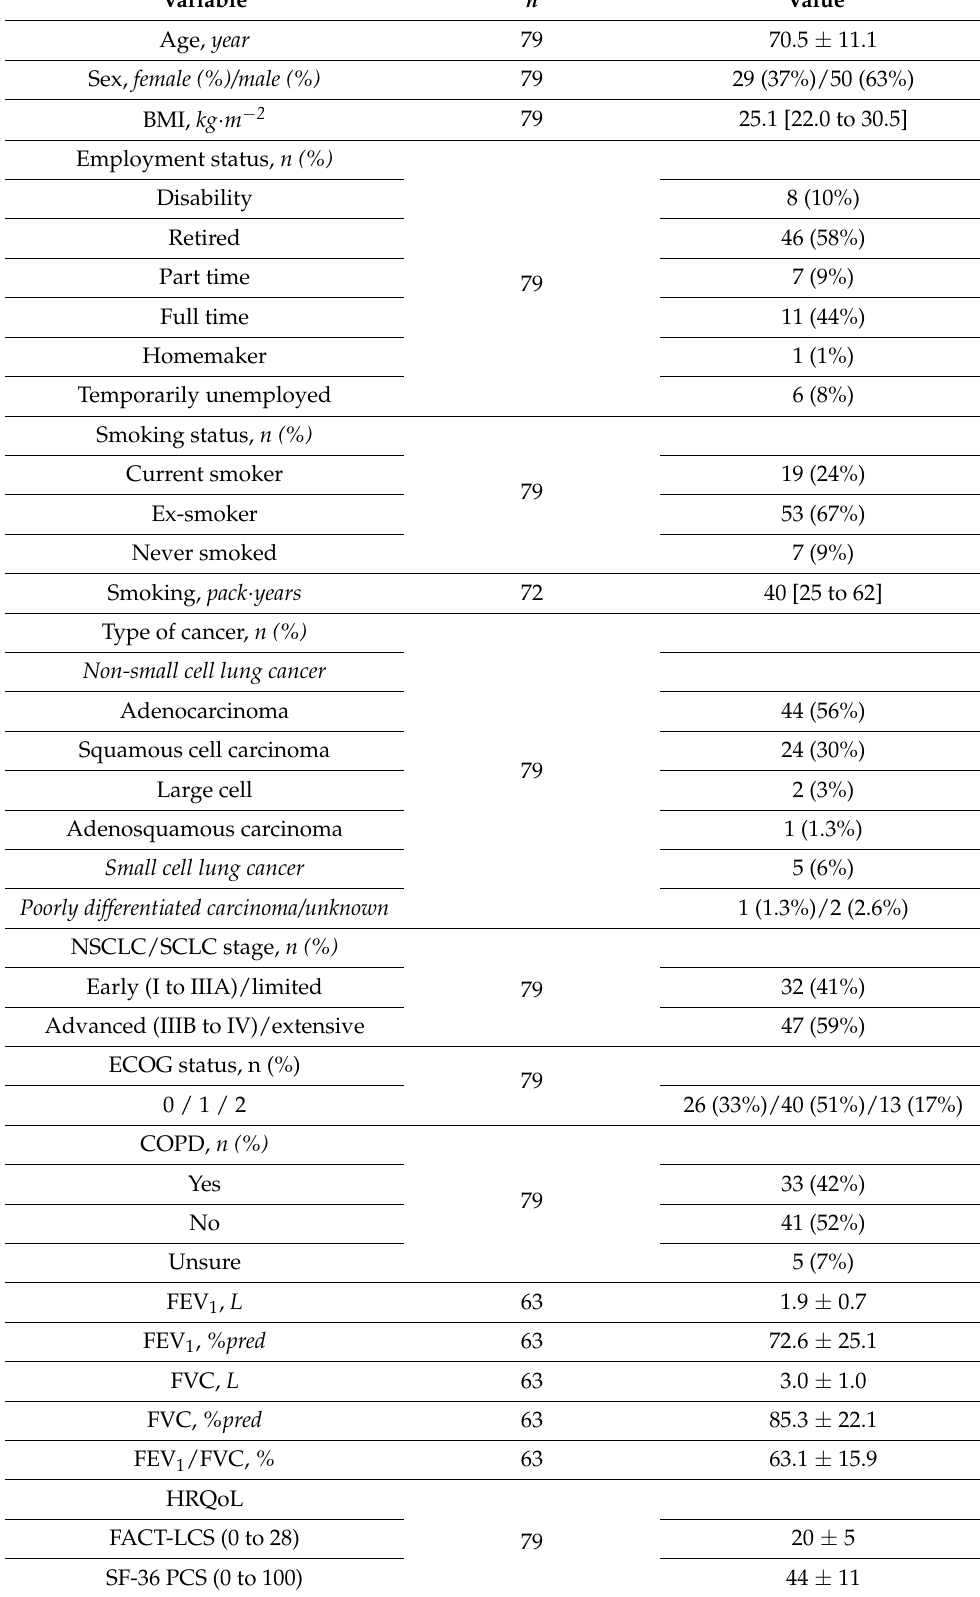
Table 1. Characteristics of the 79 people with inoperable lung cancer included in the